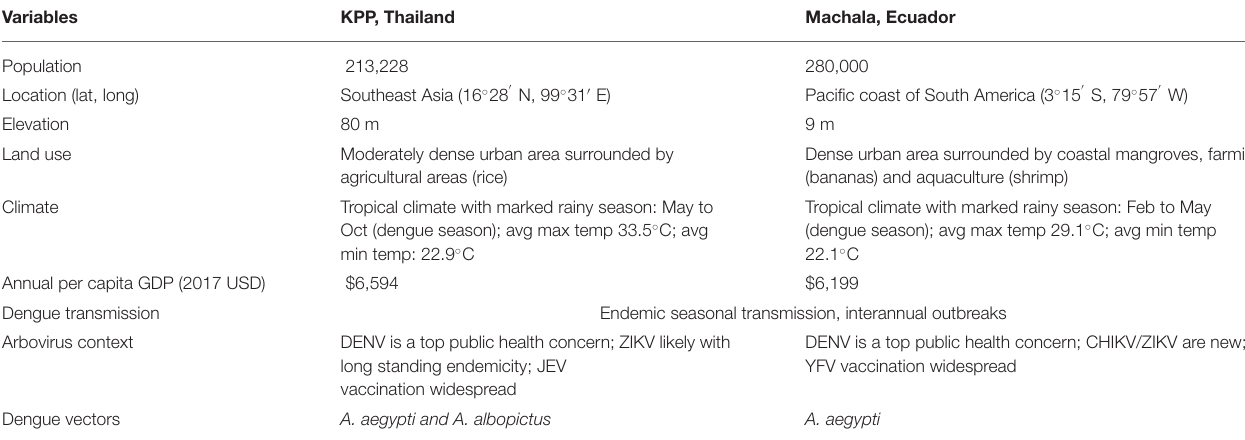
TABLE 2 | Comparison of key features of the field sites in Muang Kamphaeng Phet (KPP), Thailand, and Machala, Ecuador.